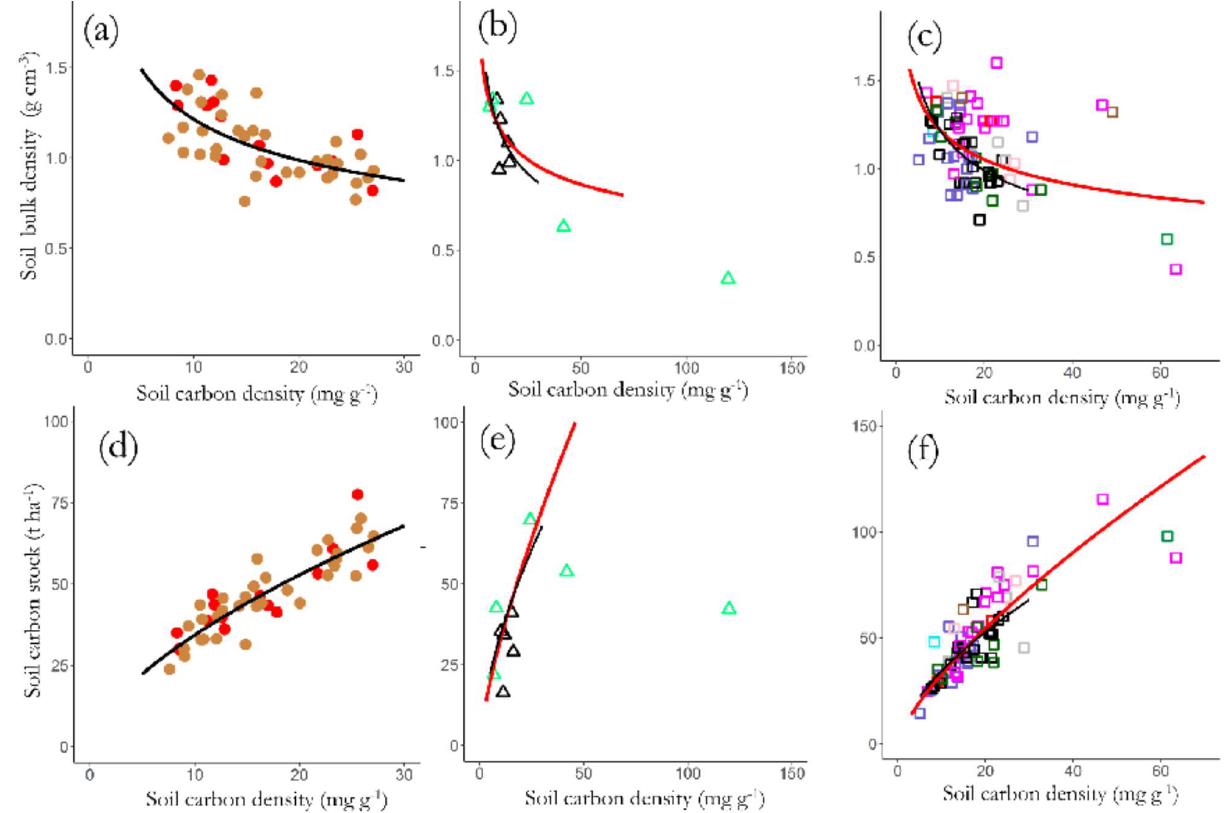
Figure 12. Variations in bulk density (a) LAC, (b) HAC and (c) arenic soils, and top-soil SOC stocks, and SOC stocks of (d) LAC, (e) HAC and (f) arenic soils as a function of SOC content. Significant regression lines (see text for details) for each soil group are plotted together for comparison.